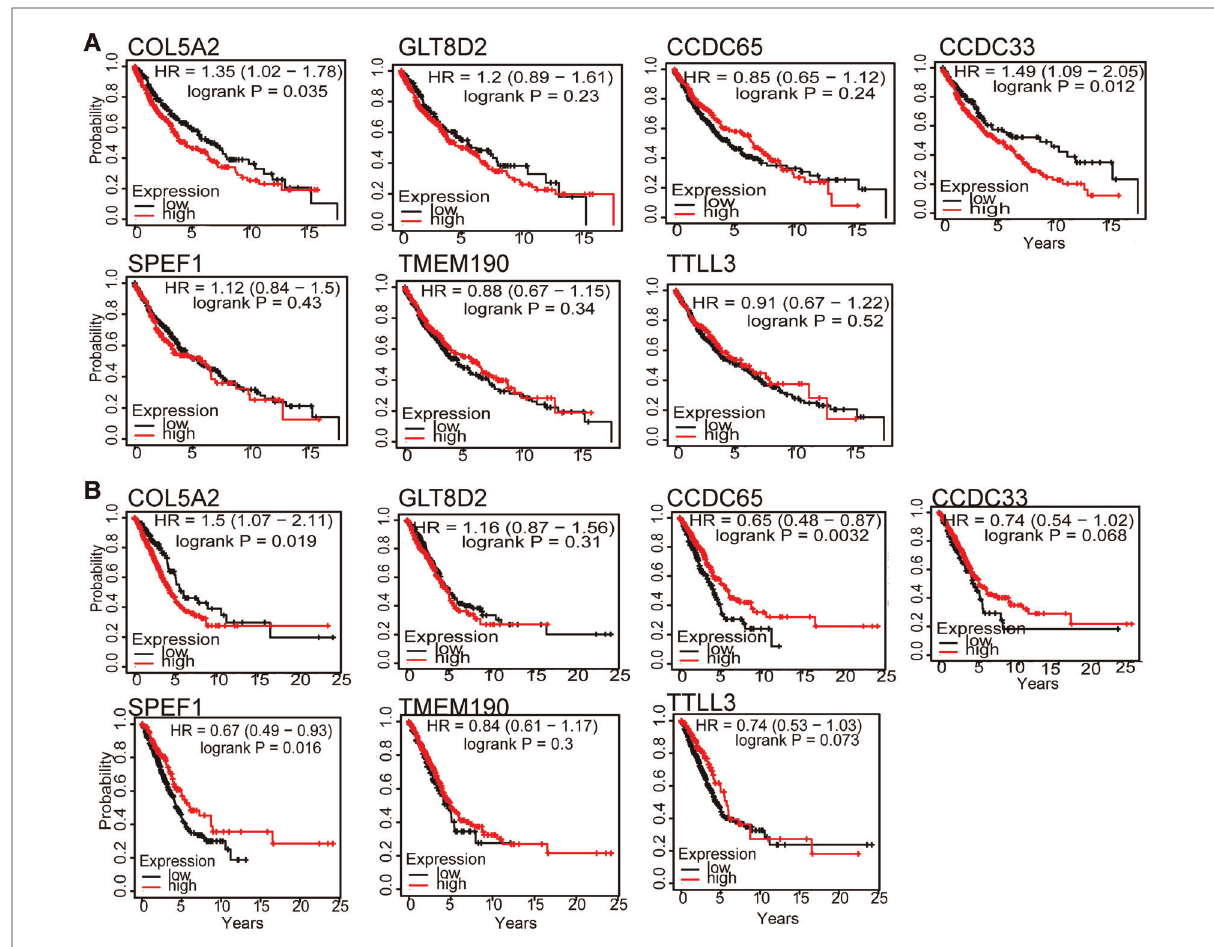
FIGURE 4 Hub genes survival curve for seven genes in LUSC ( A ) and LUAD ( B ). The horizontal axis is survival time, and the vertical axis is the overall survival rate.